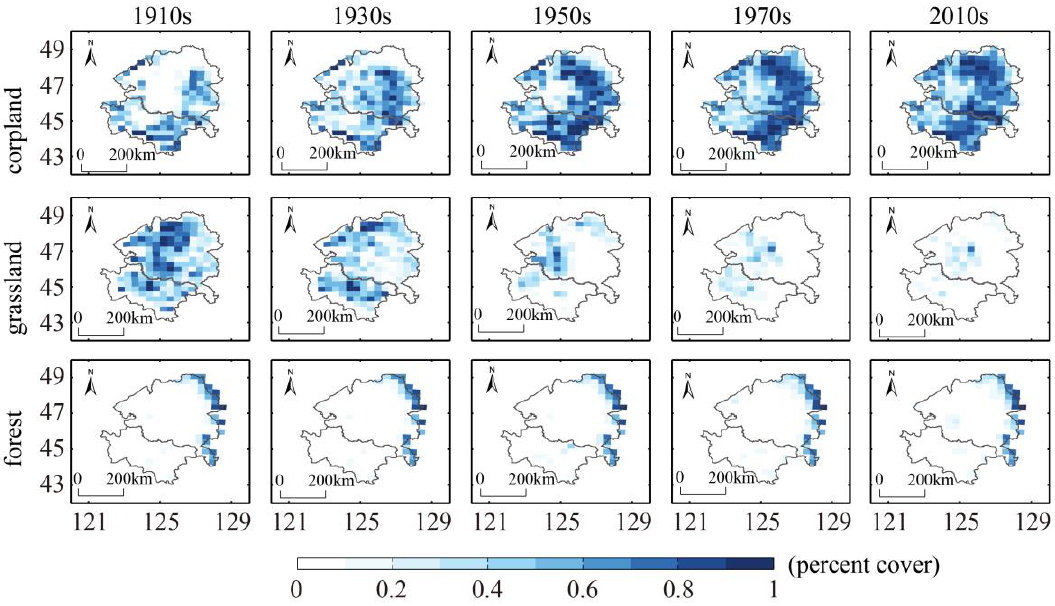
Figure 3. Spatial patterns and dynamics of the three LULC classes in the 1910s–2010s. Maps in the 1980s, 1990s and 2000s are not shown here because of their visual similarities with the 1970s and